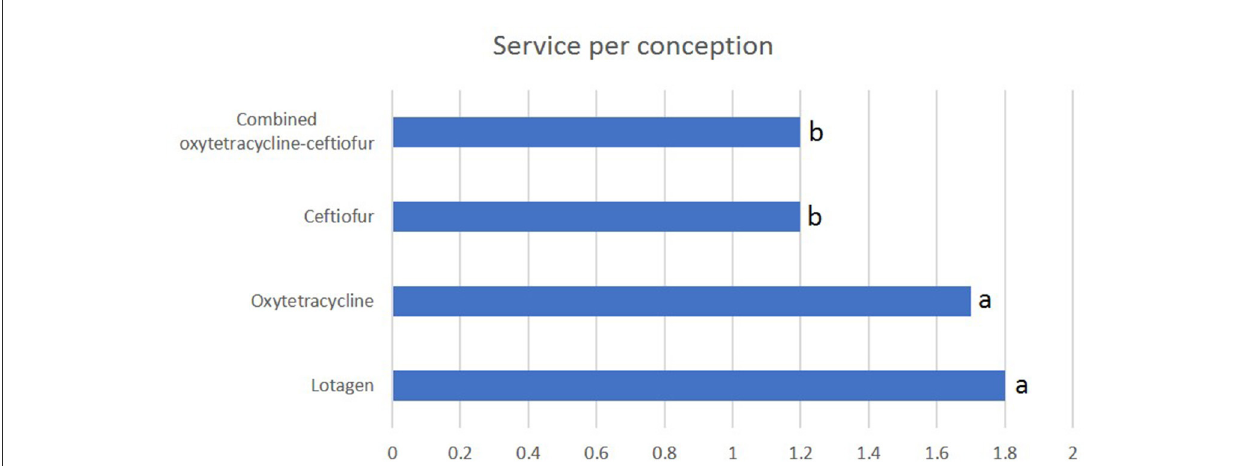
FIGURE1 Recovery rate in different protocols used for the treatment of endometritis in dromedary camels. The main criterion for assessment of recovery was returning to normal uterine thickness (5–6mm) as measured by ultrasound device 14 days post-treatment. Columns with different letters indicate a significant difference ( P < 0.05).